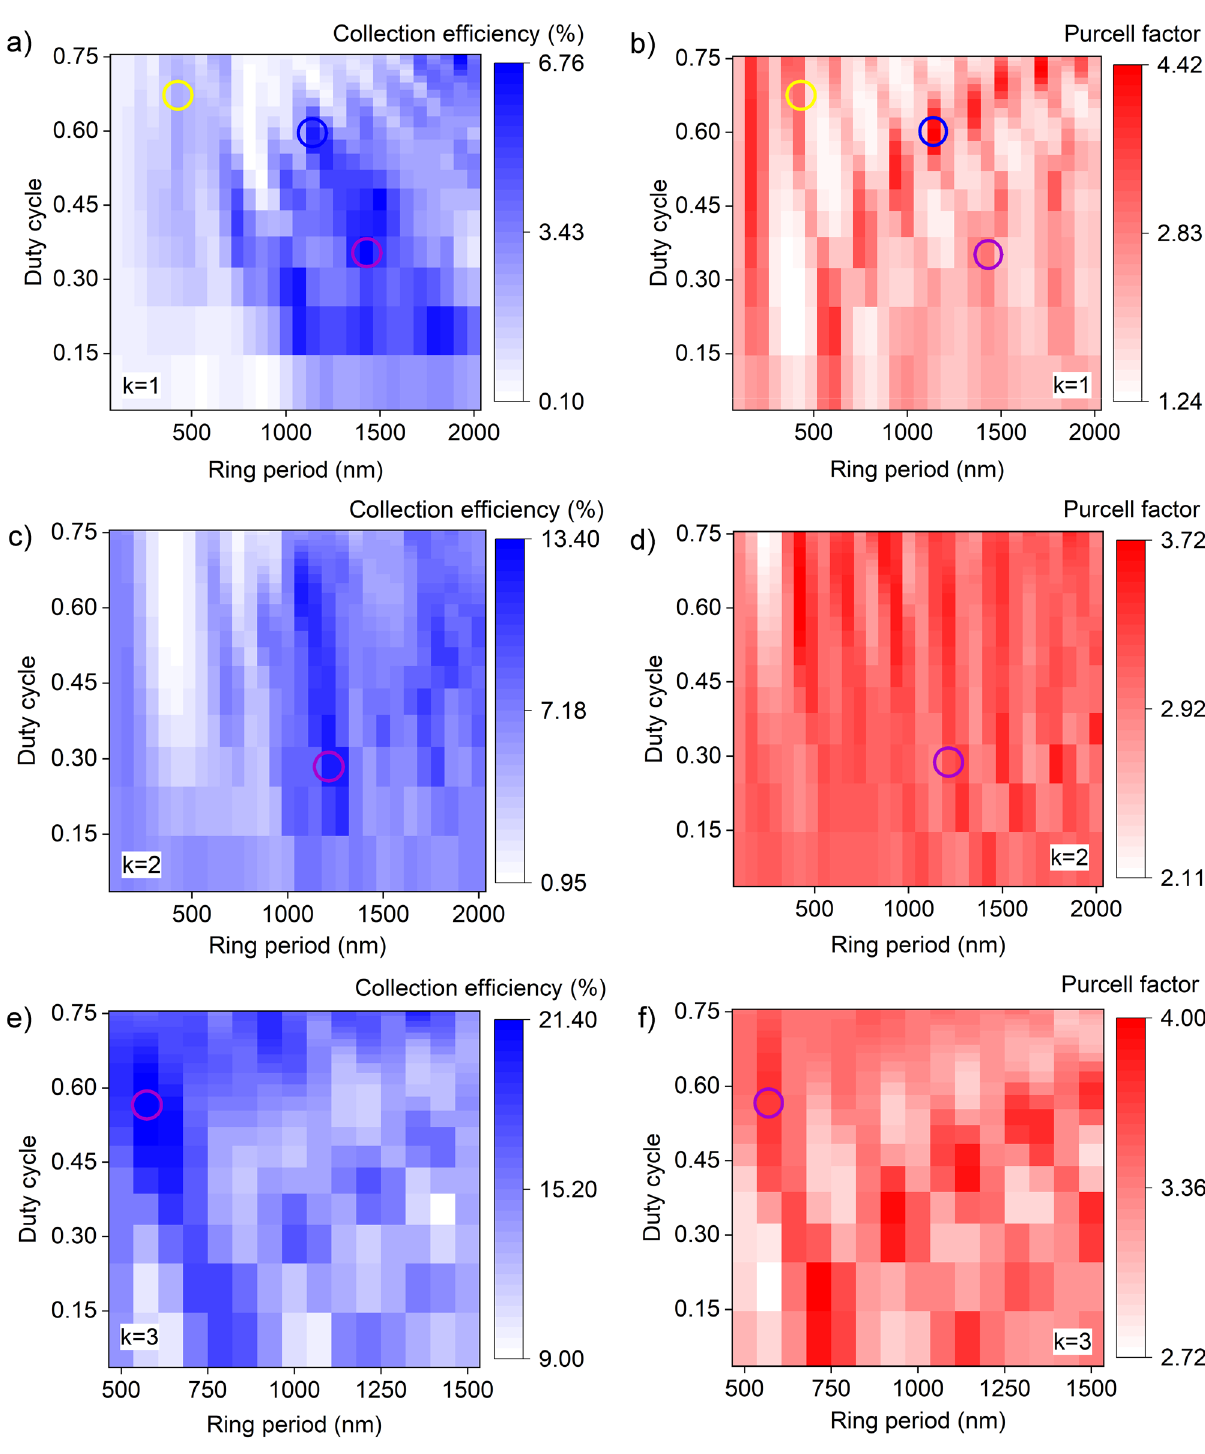
Figure 5. Apodization results for the bullseye structure. ( a , c , e ) Collection efficiency and ( b , d , f ) Purcell factor as a function of ring period and duty cycle for the first ring (k = 1), the second ring (k = 2), and the third ring (k = 3), respectively. Circles highlight points where the design meets the Bragg condition (yellow), the highest collection efficiency (purple) and the highest Purcell factor (blue). After the collection efficiency is maximised for a ring, it is fixed in dimension before next ring is added and optimised. For these simulations the fibre is included 2 microns above the bullseye and the field imaged 3 microns above the bullseye. This field is used to generate the far field emission